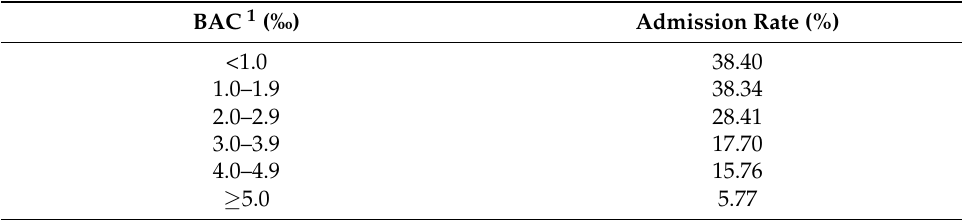
Table 1. Admission rate of patients to ED depending on their blood alcohol concentration.